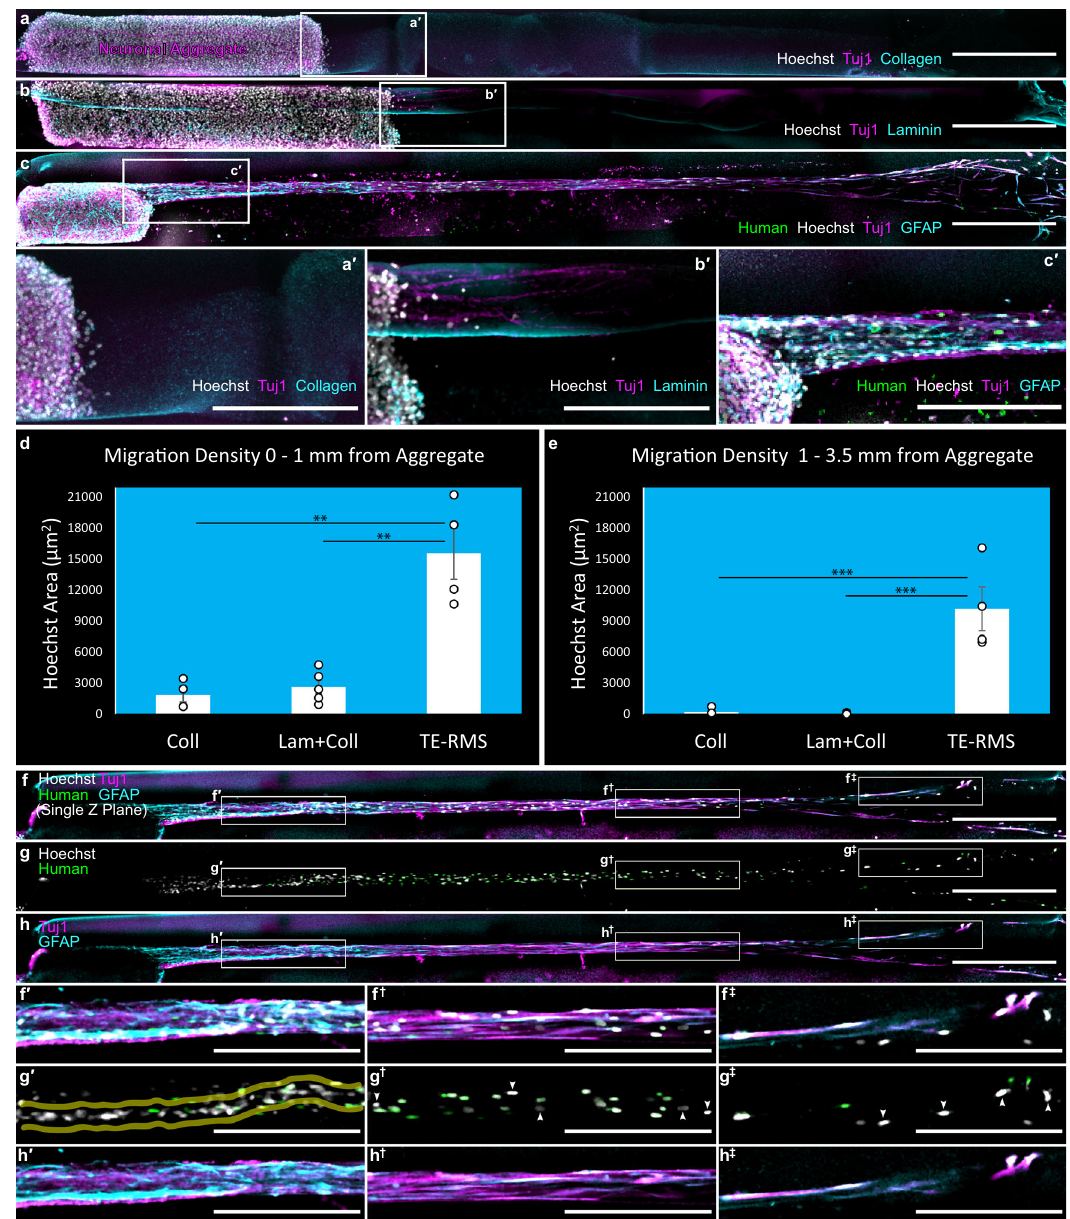
Fig. 6 Migration of immature rat neurons is facilitated by human TE-RMSs in vitro. Immature neuronal aggregates prepared from the rat cortex were inserted in one end of human GMSC-derived TE-RMSs and acellular collagen controls, and these assembled in vitro migration assays were then fi xed 72 h later for immunolabeling and analyses. Compressed z stacks of stitched confocal images are displayed in a wide view with all channels merged, consisting of Hoechst (nuclei) and Tuj1 (neurites) channels, along with either Collagen in the representative acellular collagen control ( a ), Laminin in the representative acellular collagen/laminin control ( b ), or Human nuclei and GFAP in the representative human TE-RMS ( c ). Call-out boxes provide magni fi ed views proximal to the aggregate in each column ( a ′ – c ′ ). Quanti fi cation of the area of Hoechst-positive, Human-negative nuclei (nuclei from the immature neuronal aggregate) is provided for all groups for 0 – 1 mm from the aggregate ( d ) and 1 – 3.5 mm from the aggregate ( e ). Data are displayed as mean ± SEM with points to indicate individual sample values; n = 4, 5, and 4 for Coll, Lam + Coll, and TE-RMS, respectively (** p < 0.005, *** p < 0.001 with Bonferroni correction for multiple comparisons). A single z plane of a stitched confocal image from a representative human TE-RMS containing Hoechst, Human Nuclei, Tuj1, and GFAP channels is displayed in a wide view with all channels merged ( f ), with just the nuclear labels ( g ), and with just the astrocyte and neuron-speci fi c cytoskeleton labels ( h ). Call-out boxes provide magni fi ed views along the TE-RMS proximal to the aggregate ( f ′ – h ′ ), ~2.5 mm from the aggregate ( f † – h † ), and ~3.5 mm from the aggregate ( f ‡ – h ‡ ). Opaque yellow outlines in g ′ highlight the narrow path for chain migration forged by immature neurons through the TE-RMS. White arrows in g † and g ‡ indicate the Hoechst + /Human- nuclei of immature neurons migrating the length of the TE-RMS. Scale bars: 500 microns ( a – c ; f – h ), 250 microns ( a ′ – c ′ ; f ′ – h ‡